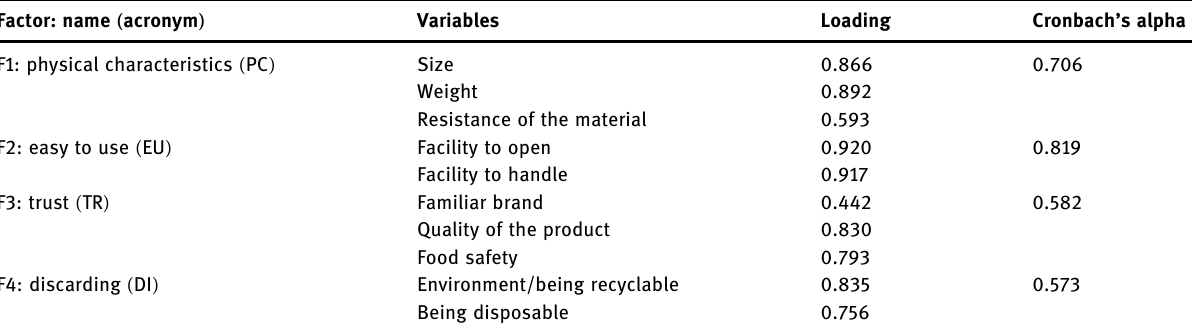
Table 1: Results obtained from FA and reliability of the factors Factor: name ( acronym )